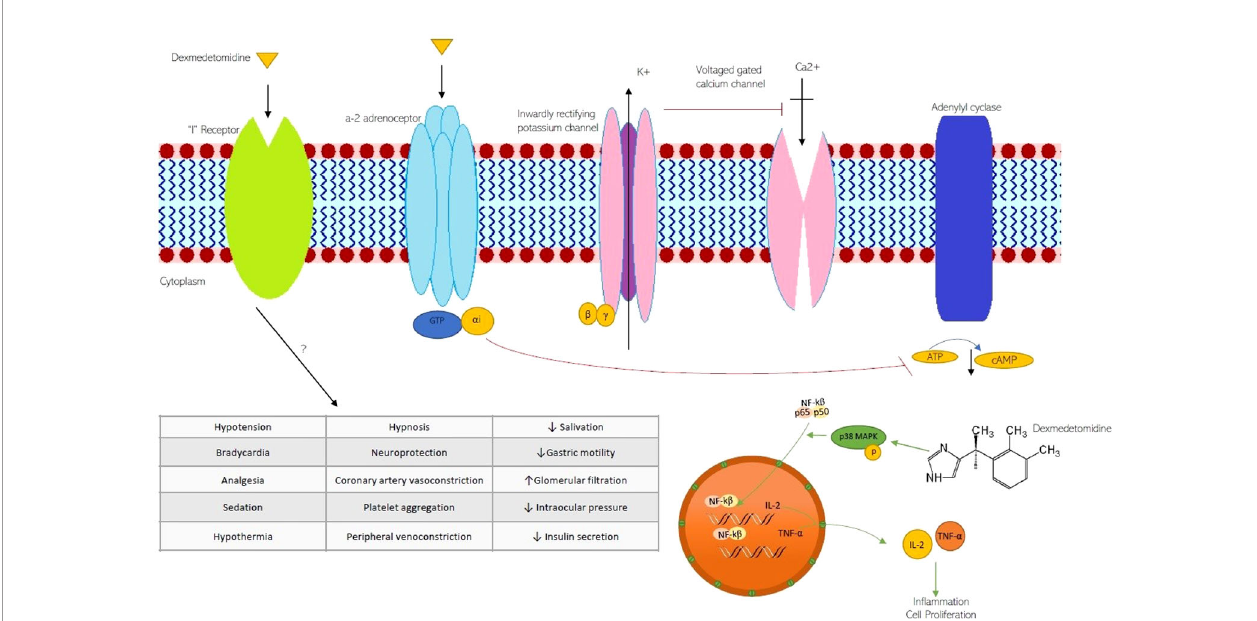
FIGURE 1 | The molecular signaling pathways trigger by DEX and pathophysiological effects on ion channels and G-protein-coupled receptors. K + , potassium channel; Ca 2+ calcium channel; GTP guanosine triphosphate; a i alpha inhibitory unit; cAMP c- adenosine monophosphate; NF- k B nuclear factor kappaB; MAPK, Mitogen-Activated Protein Kinases.